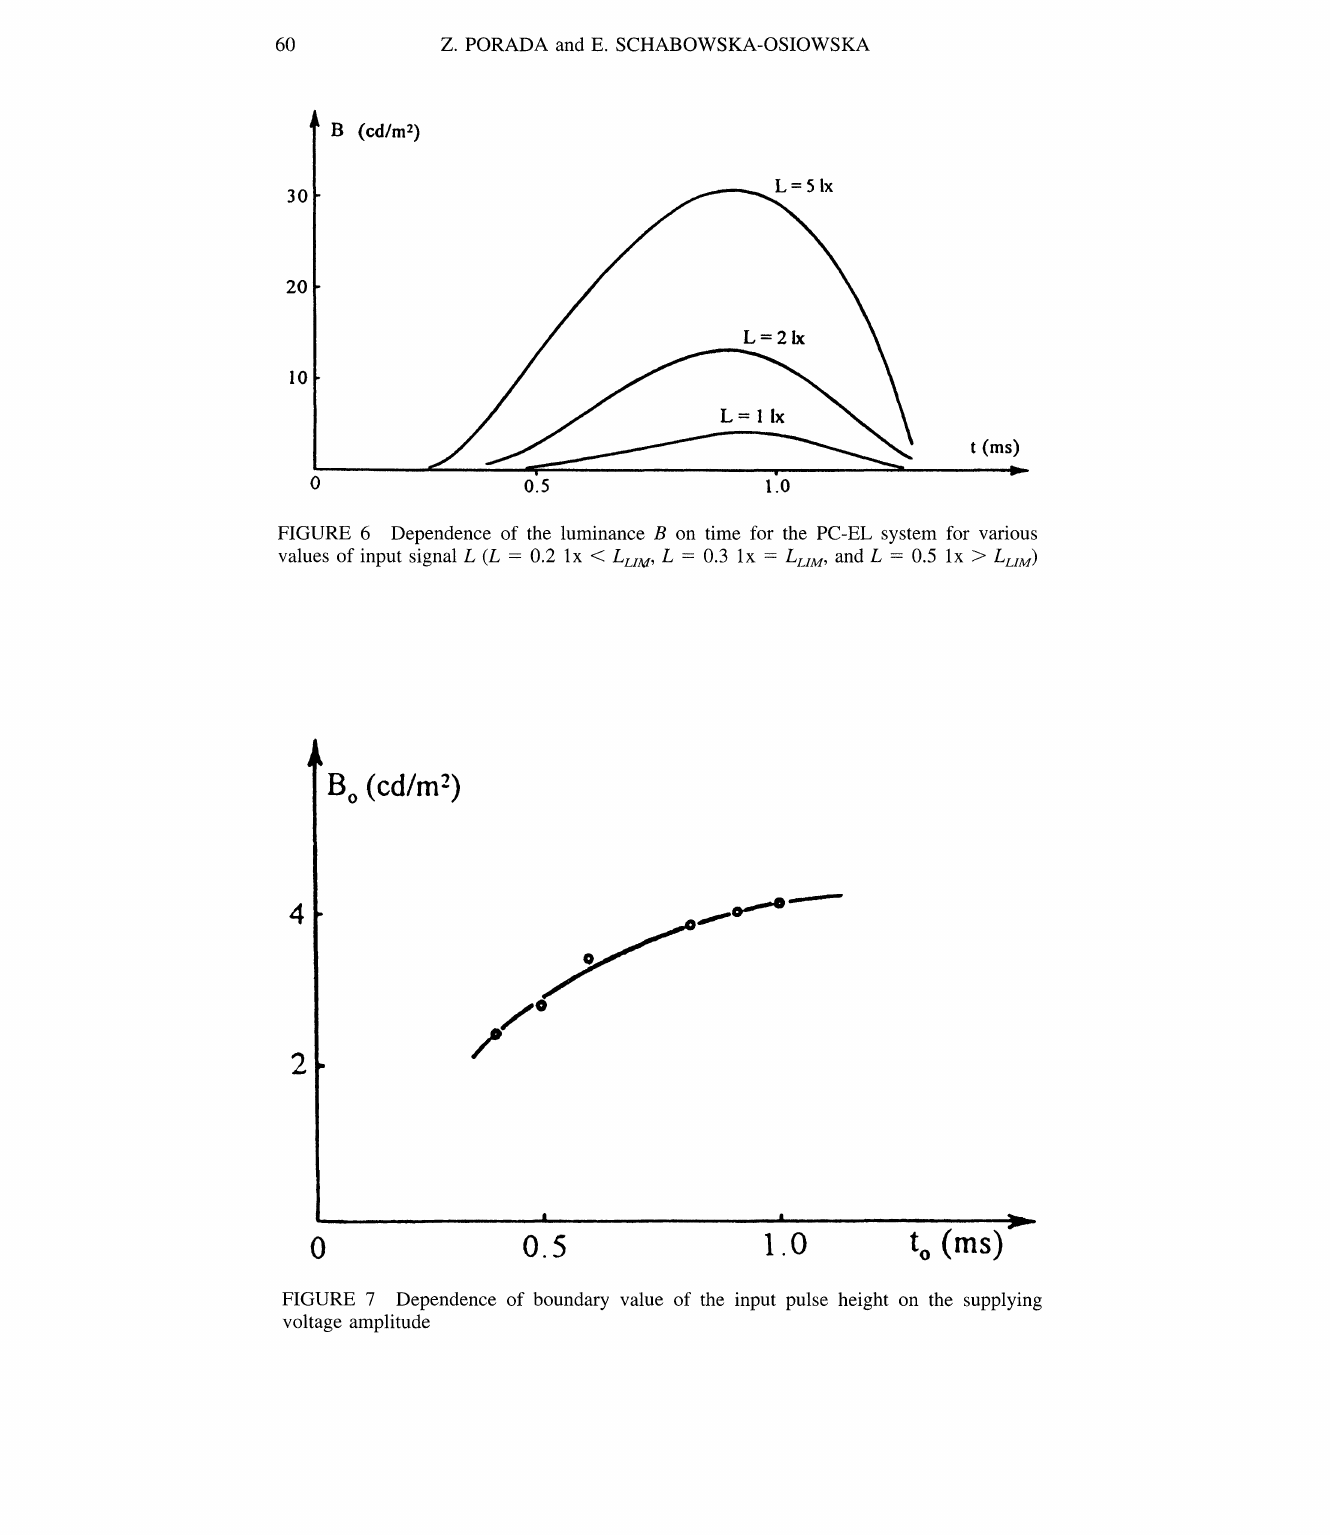
FIGURE 7 Dependence of boundary value of the input pulse height on the supplying voltage